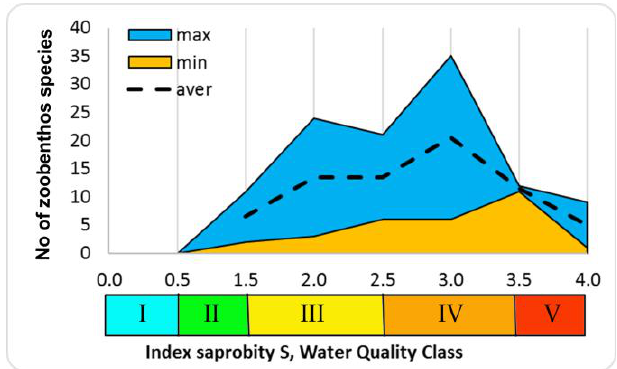
Figure 7. The species richness of zoobenthos in the Styr River in different zones of Index saprobity S and Classes of Water Quality.